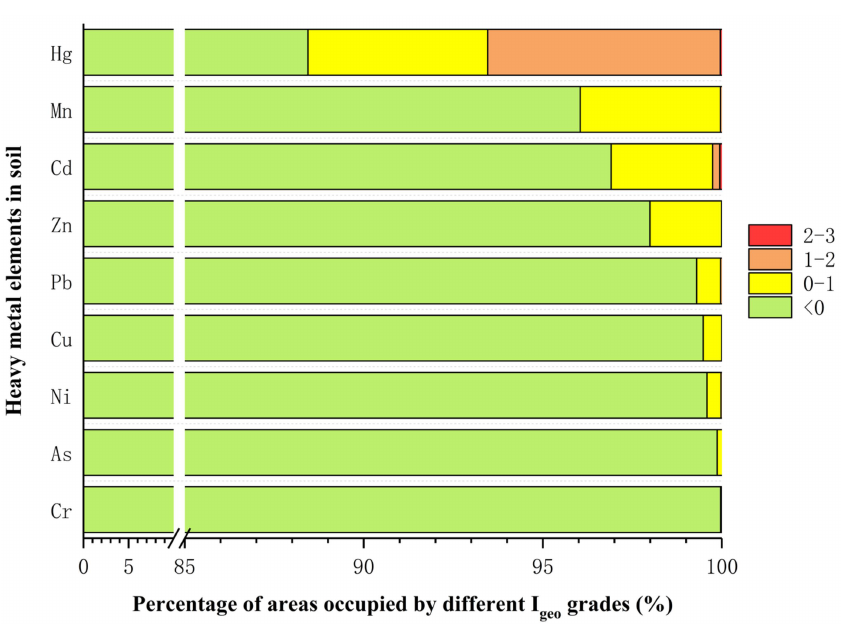
Figure 6. Geo-accumulation index (I geo ) of Zn, Mn, Cd, Hg, As, Ni, Cu, Pb, and Cr in soil samples, in percent. The classification standards of I geo are Level 1 (green) pollution-free (I geo < 0); Level 2 (yellow) mild pollution (0 < I geo < 1); Level 3 (orange) mild-to-moderate pollution (1 < I geo < 2); and Level 4 (red) moderate pollution (2 < I geo < 3).